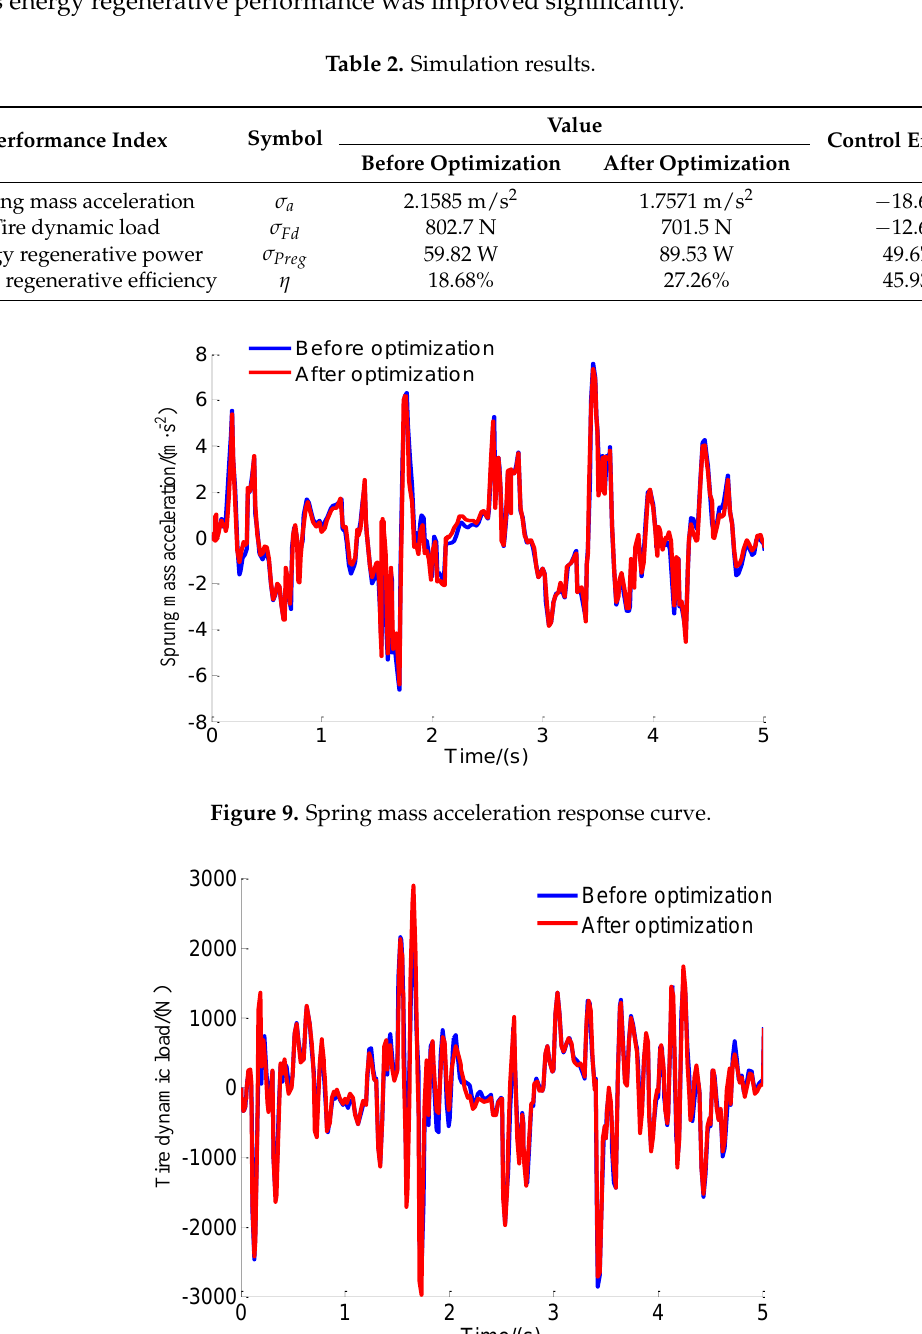
Figure 11. Energy regenerative power response curve. 5.4. Test and Analysis In order to further verify the optimization results, the EHA prototype is redeveloped based on the optimization results, and the bench test is carried out as shown in Figure 12. In addition, the EHA actuator in Figure 4 is the original EHA actuator before optimization, and the EHA actuator in Figure 12 is the optimized one. Due to the limitation of test conditions, the test is conducted only for the spring mass acceleration and the energy regenerative power of the semi-active suspension with an EHA. In the test, the DH186 acceleration sensor produced by Donghua testing company is used to collect the spring mass acceleration signal, and the rectifier is used to rectify the three-phase alternating current generated by the DC brushless motor. At the same time, the Donghua DH5902 data acquisition system is used to collect the feed voltage signal. Additionally, according to the relationship between power, voltage, and the internal resistance of the motor, the instantaneous energy regenerative power can be obtained. Under the condition that the sinusoidal is input at the frequency of 2 Hz, the amplitude of 30 mm, and the sampling time of 10 s, the test results of the spring mass acceleration response and energy regenerative power response of the semi-active suspension with an EHA before and after optimization are shown in Figures 13 and 14, respectively.